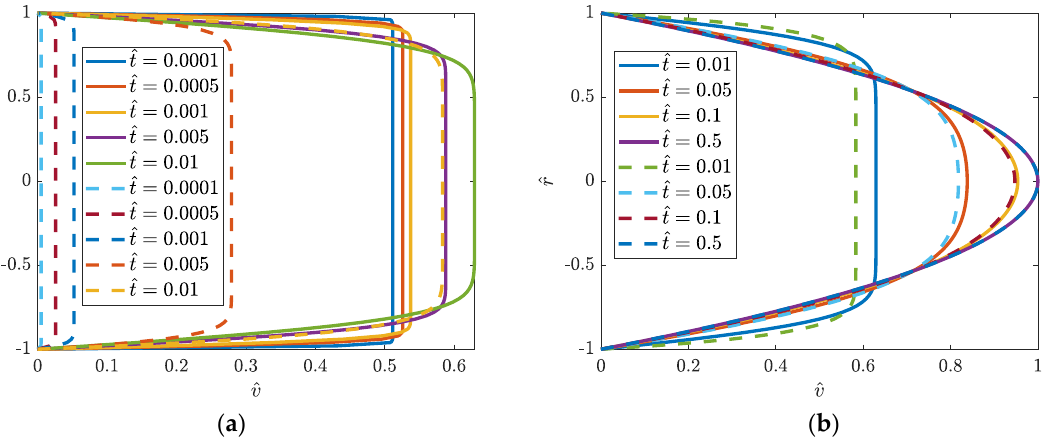
Figure 12. Comparison of Das and Arakeri model (dotted lines; ˆ t 0 = 0.01) with Anderson and Tiseth model (solid lines): ( a ) ˆ t ≤ 0.01, ( b ) ˆ t ≥ 0.01